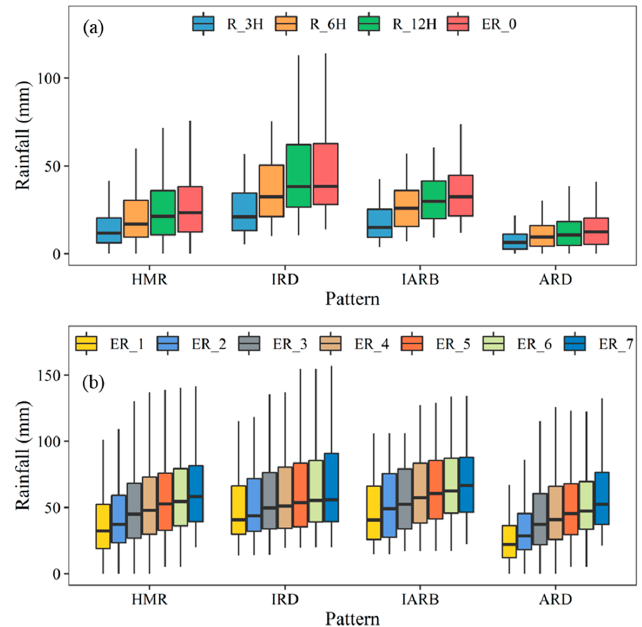
Figure 6. Boxplots of ( a ) the intraday rainfall conditions and ( b ) cumulative 7-day effective rain- fall